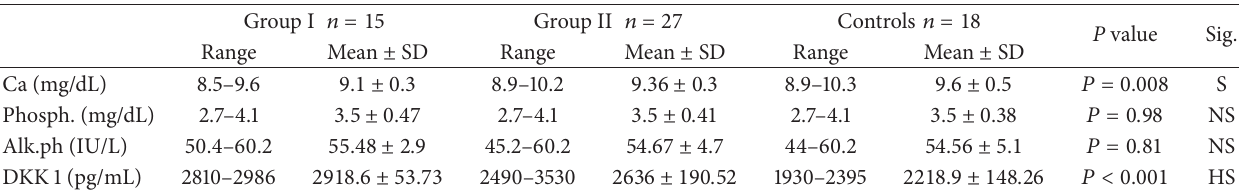
Table 2: Laboratory data in groups I, group II, and controls. Comparison between three groups by ANOVA. Group I 𝑛 =